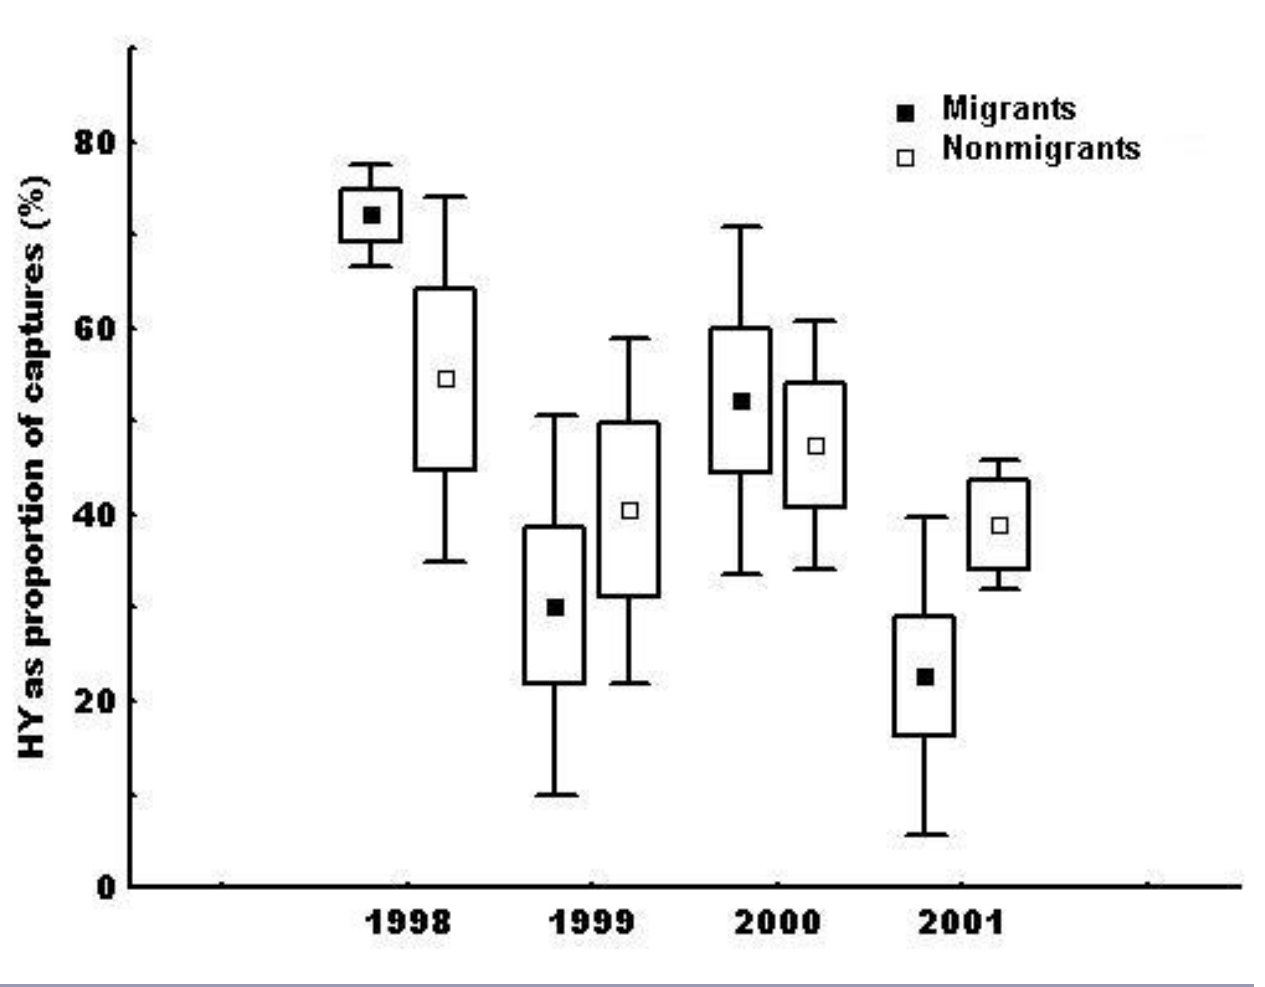
Fig. 6 . Mean proportion of hatching-years (HY) among all captures during the core period of mist-netting for species qualifying in more than one year. The symbols represent the median, the boxes contain a range of 25–75%, and the whiskers illustrate the